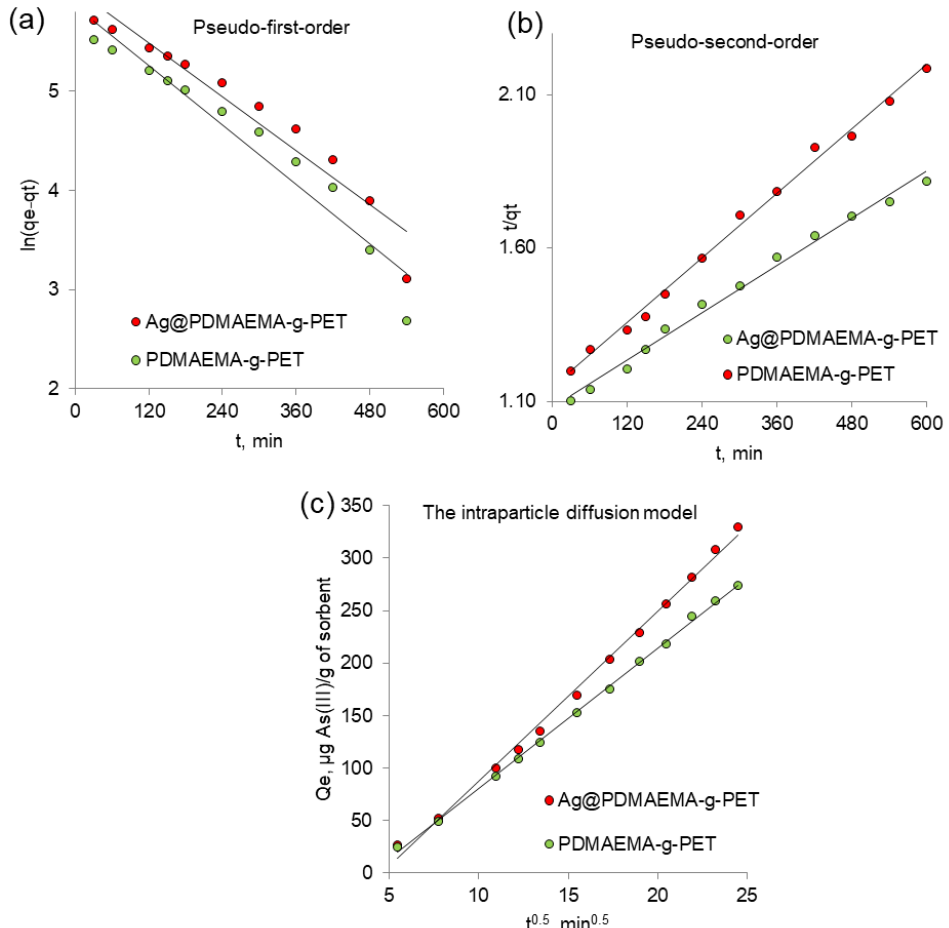
Figure 9. Kinetics of As(III) adsorption according to the studied kinetics models: pseudo-first order (a) , pseudo-second-order (b) and the intraparticle diffusion model (c) .